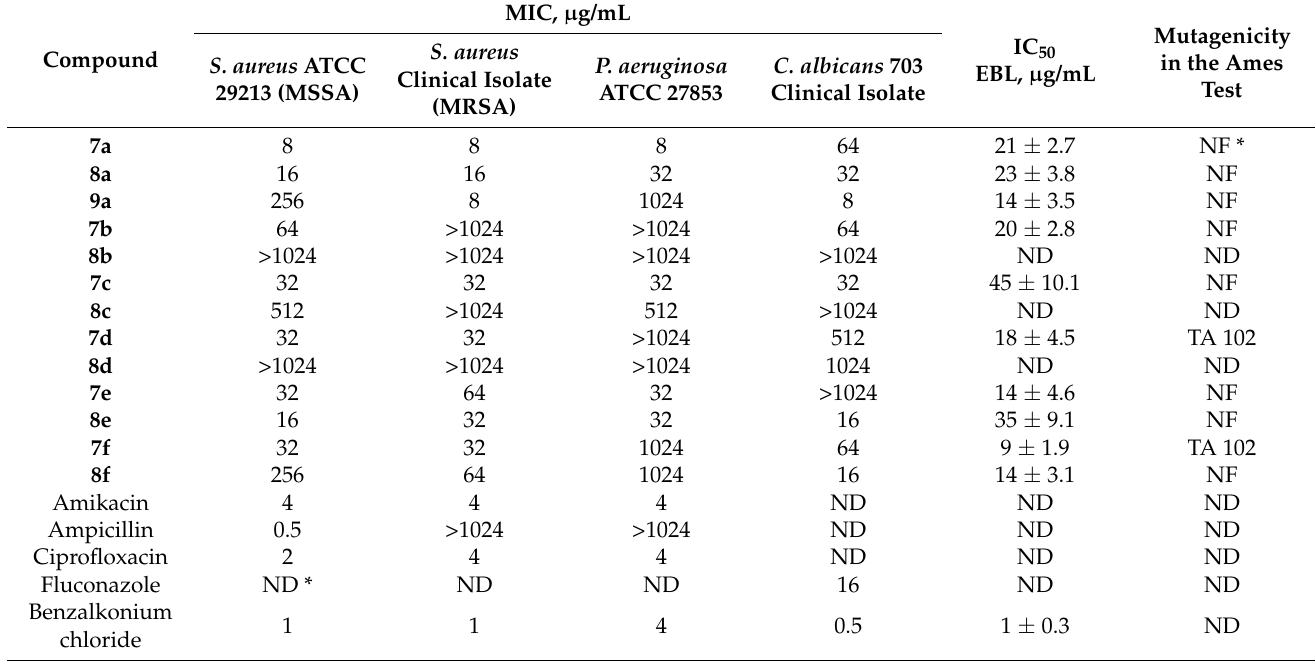
Table 1. Antibacterial and antifungal activities, and cytotoxicity and mutagenicity of